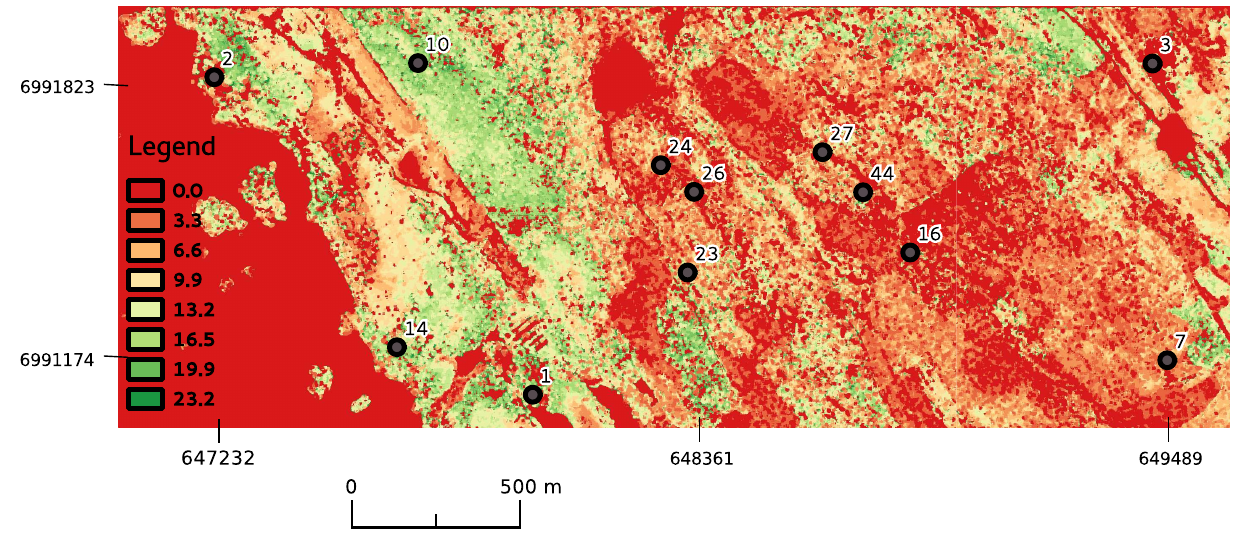
Figure 6. A portion of the gap height raster with some of the sample plots superimposed. The gap heights are in meters.